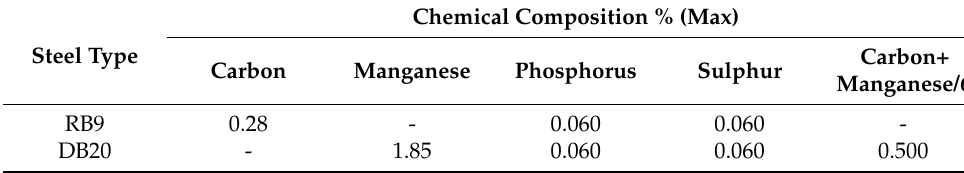
Table 3. Chemical composition of steel (TIS,